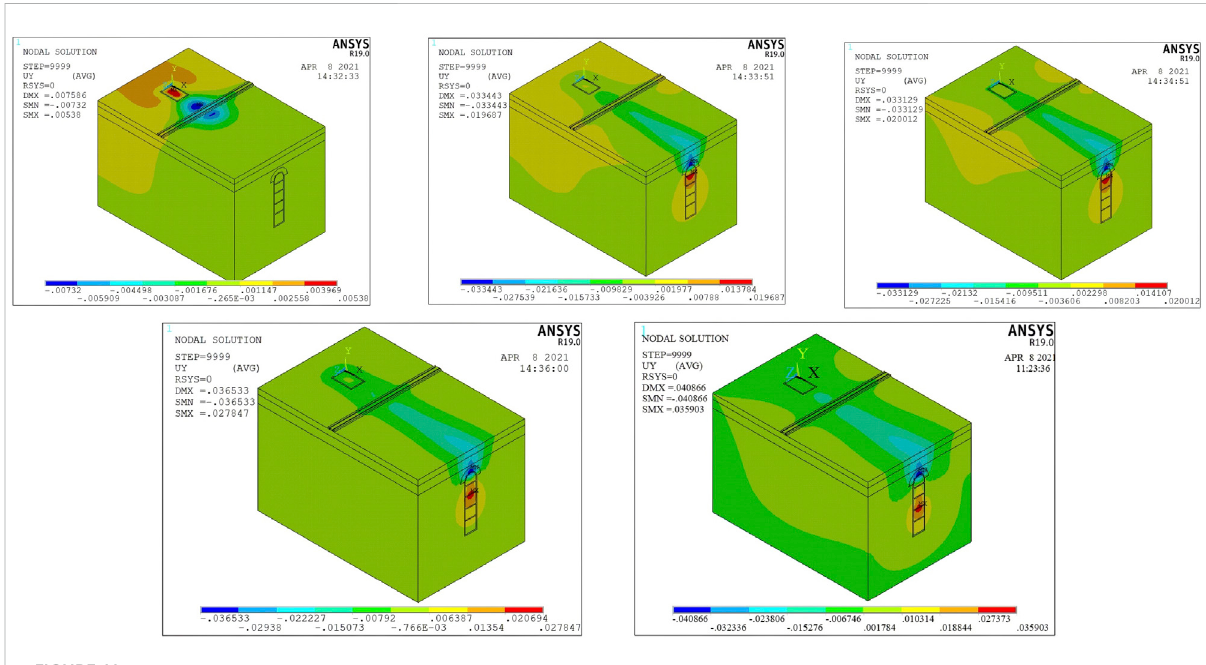
FIGURE 11 Ground surface settlement cloud chart of pilots under-passing existing railway line.